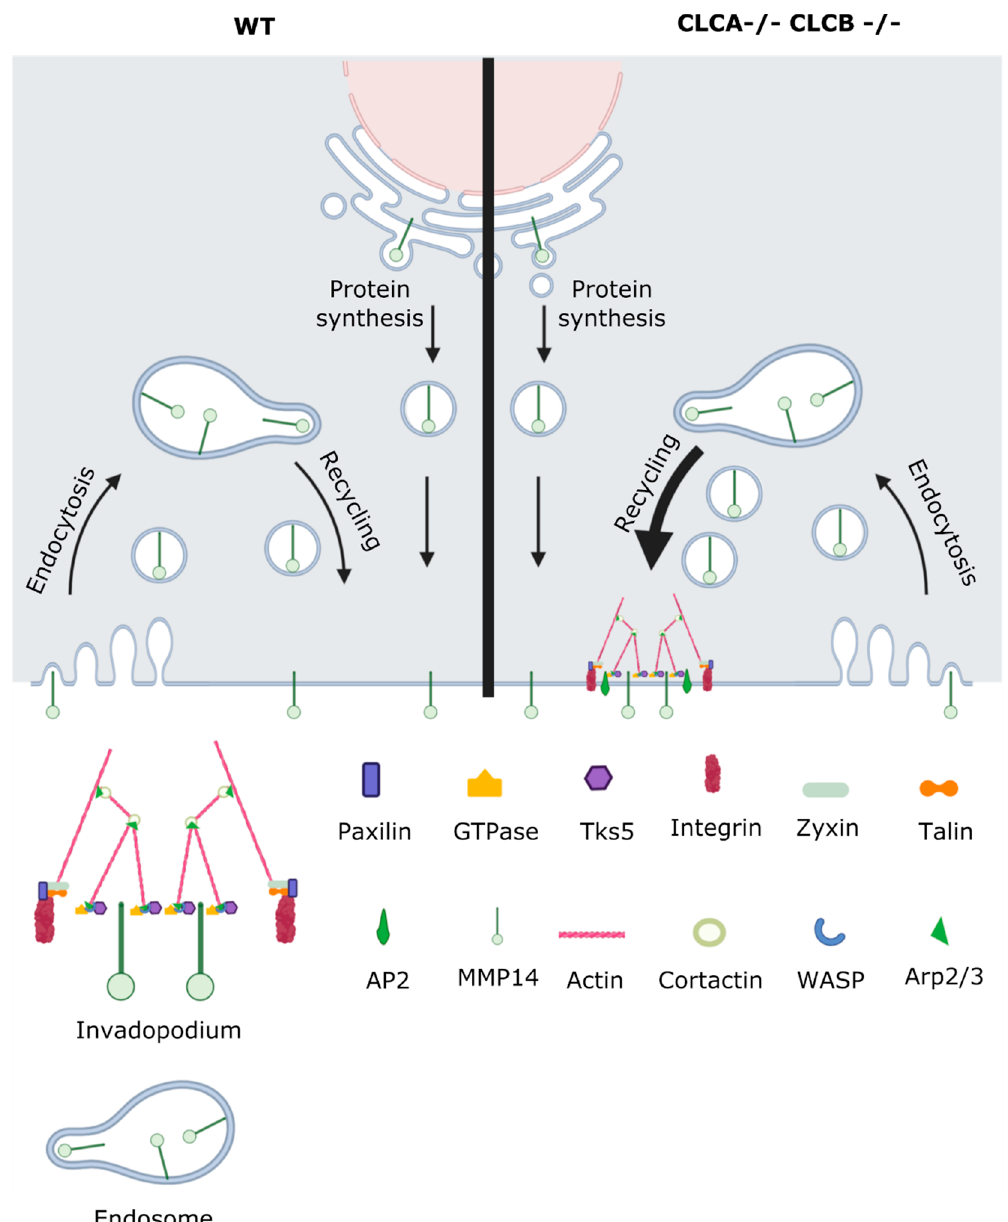
Figure 9. Loss of CLCs induces invadopodia formation by actin polymerization and MMP14 recruitment. Schematic showing upregulation of MMP14 recycling in CLCA − / − CLCB − / − cells causing invadopodia formation. Supplementary Materials: The following are available online at www.mdpi.com/xxx/s1, Figure S1: CHC expression and transferrin uptake in WT, CLCA − / − , CLCB − / − and CLCA − / − CLCB − / − cells, Figure S2: Dynamics of CME in WT, CLCA − / − , CLCB − / − and CLCA − / − CLCB − / − cells Figure S3: Quantification of actin patch formation, Figure S4: Trans-complementation of QQN mutant does not rescues actin patch formation, Figure S5: Manders correlation of AP2 and Phalloidin and De- letion of CLCA and CLCB in U373 cells induces the accumulation of MMP14s, Figure S6: Knock out of CLCA and CLCB increases recycling of MMP14 to the plasma membrane, Figure S7: Cyclo- heximide treatment causes similar MMP14 turnover in WT and CLCA − / − CLCB − / − cells , Figure S8: HIP1R localization in endocytic spots, Video S1: Live CLCa back compensation, Video S2: U373 WT gelatin digestion Video S3: U373 CLCA − / − CLCB − / − gelatin digestion. Author Contributions: M.M. designed and performed experiments, analyzed data and wrote the manuscript. F.M. designed and performed experiments, and analyzed data. D.B. designed ECM. degradation assay. E.A. performed actin patch formation and W.B. experiments. E.C.B. performed experiments and analyzed data. E.A.C.-A. supervised the experiments. S.B. supervised the project,